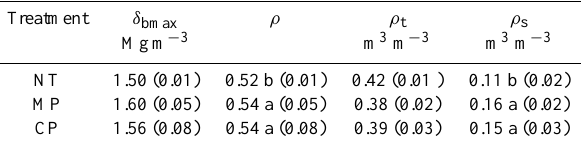
Table 3. Maximum soil density ( δ bmax ) , total porosity ( ρ) textu- ral porosity ( ρ t ) and structural porosity ( ρ s ) under no-tillage (NT), moldboard-plow (MP) and chisel-plow (CP) management, N = 4.